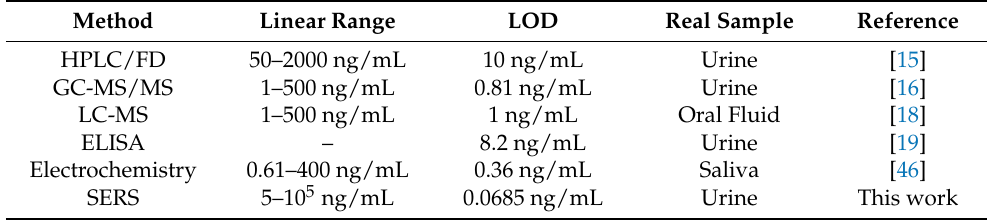
Table 2. Comparison of the sandwich-structure-based SERS strategy for MDA with other re- ported